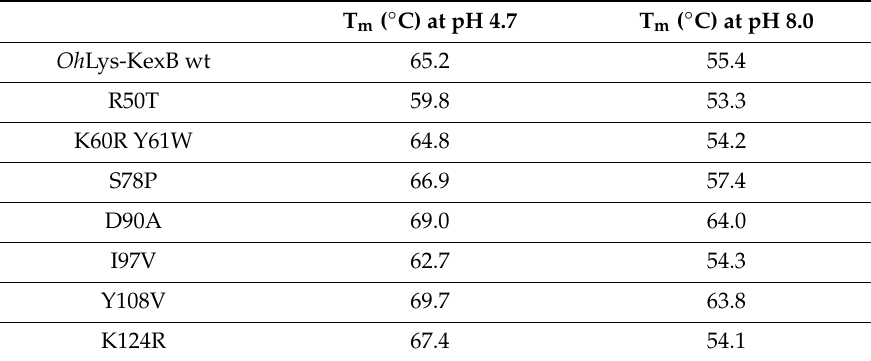
Table 4. Thermostability, as examined by